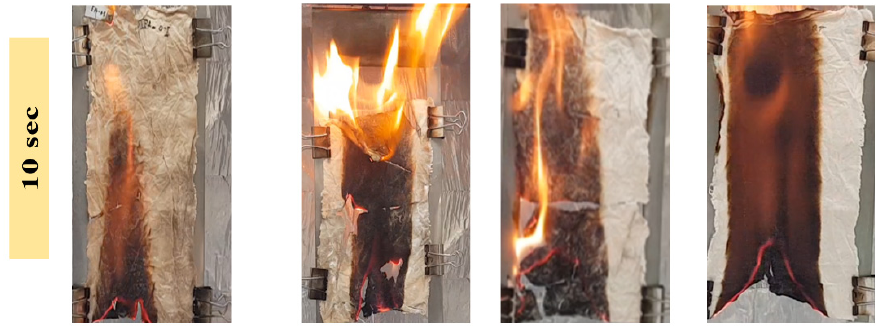
Figure 8. Images of the coated samples obtained after 10 s of flame initiation.